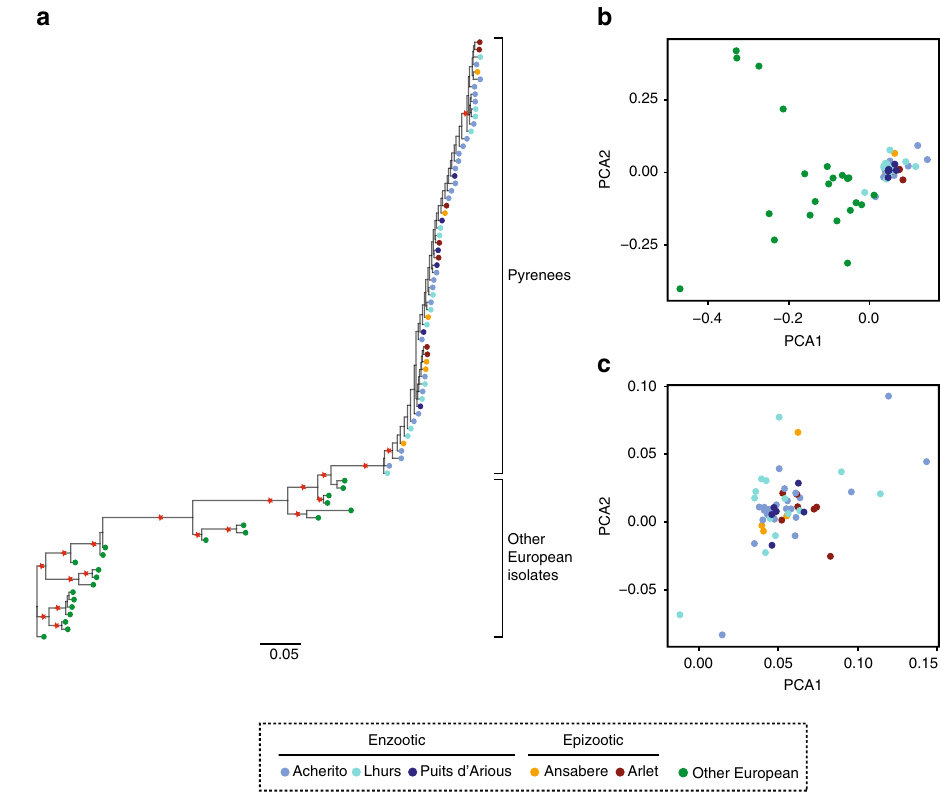
Fig. 5 Bd genetics across space and time in the Pyrenees. a Phylogeny of Bd isolates collected from the Pyrenees and other European localities. Red stars indicate bootstrap values of 100. b PCA plot of identi fi ed SNPs from Bd isolates from all localities. c PCA plot of identi fi ed Bd SNPs from Pyrenean lakes only. Sample sizes were: n = 6 (Ansabere); n = 7 (Arlet); n = 26 (Acherito); n = 14 (Lhurs); n = 6 (Puits d ’ Arious), n = 22 (other European